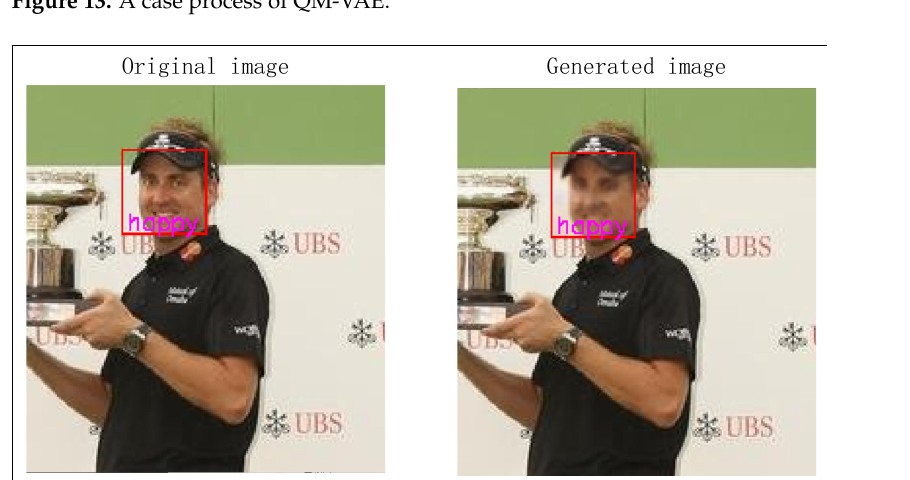
Figure 13. A case process of QM-VAE.